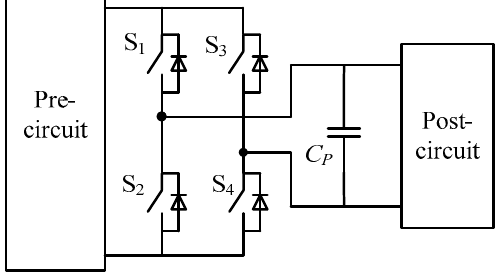
Figure 2. The general topology that can generate short currents.